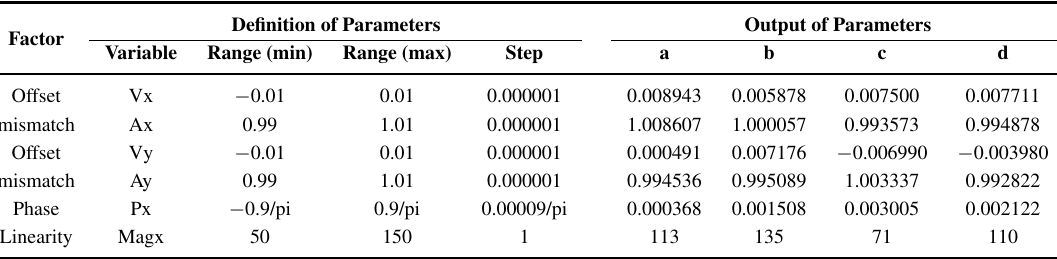
Table 2. Definition and output of